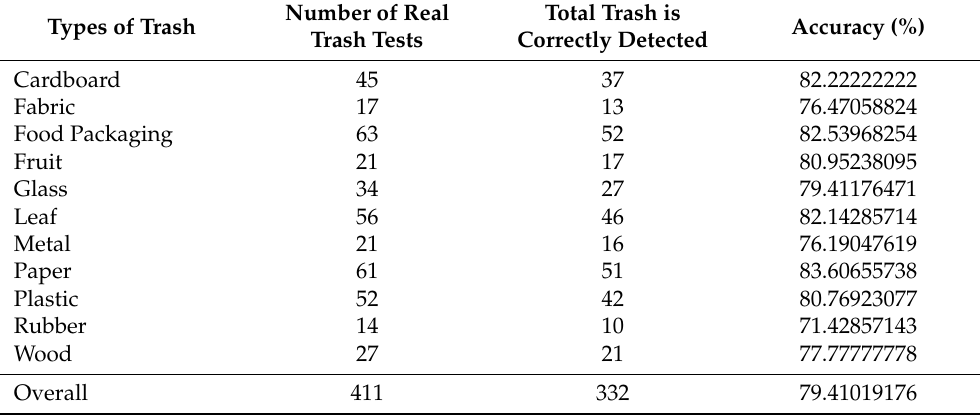
Table 6. The Accuracy of 11 Types of Trash Using a Real-Time Camera with Pre-Trained AlexNet.